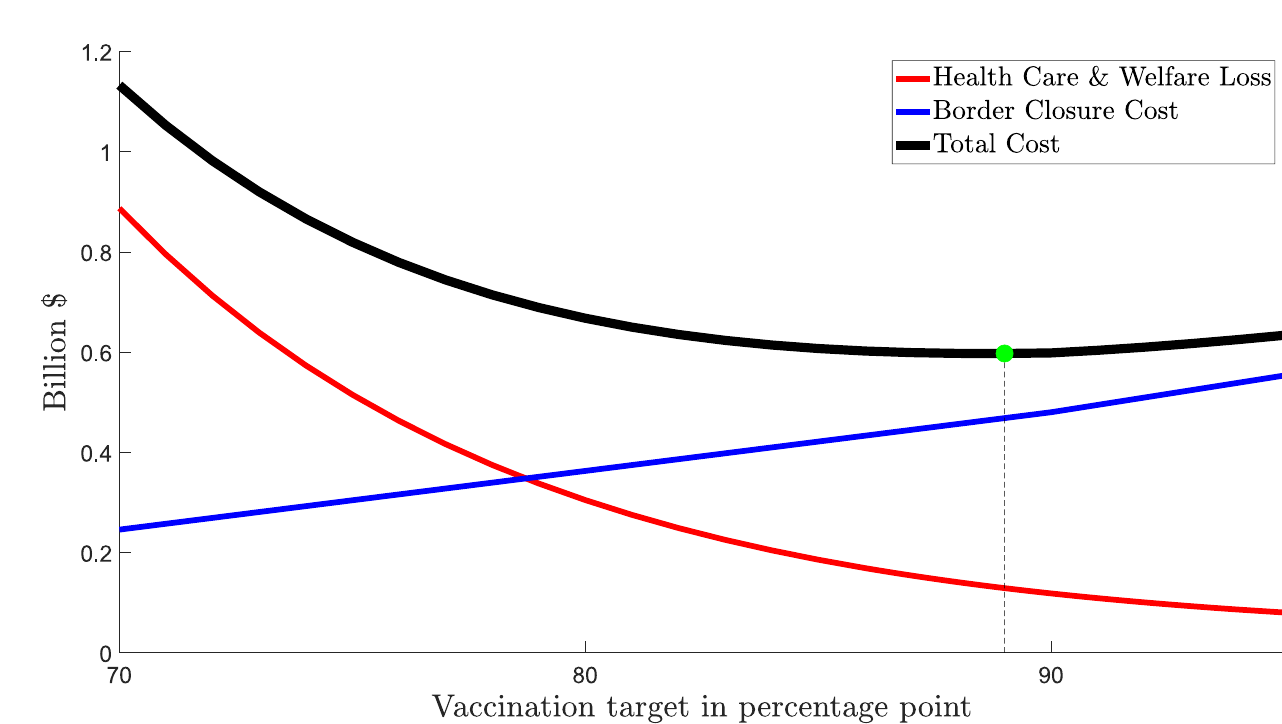
Fig 7. WA: Societal costs of different vaccination rates with respect to state border reopening. Notes about Fig 7: Including costs that vary with vaccination targets, counted from October 11 th 2021. Costs appliable to ALL vaccination targets are not included (e.g., vaccination costs, the cost of maintaining the minimal restrictions, the cost of policy interventions after the vaccination target is